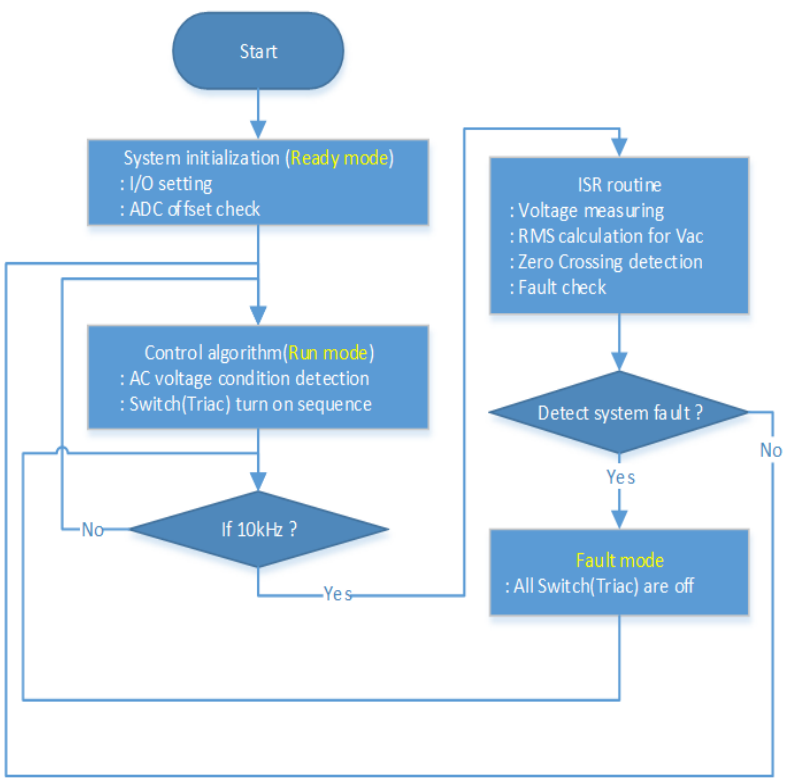
Figure 3. Flowchart of the proposed digital switching algorithm.